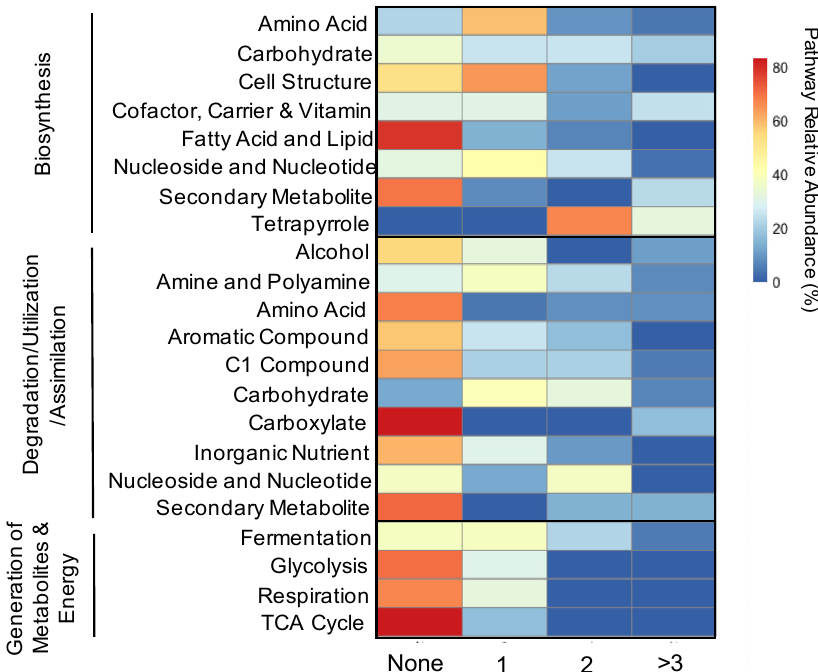
Figure 5. Relative abundances of inferred functional pathways between microbiomes of six species of Unionidae mussels sampled at the same site on the Sipsey River, AL, USA, across two years. Pathways that were not significantly different (adjusted p < 0.05) in any species (None) are presented alongside pathways that were found to be significantly different in one (1), two (2), and at least three (<3) species sampled in 2019 compared to 2016. Color denotes the percentage of inferred pathways. Parent functional pathways are labeled from the MetaCyc database version 2019. Mussel species were Lampsilis ornata , Obovaria unicolor , Elliptio arca , Fusconaia cerina , Cyclonaias asperata , and Tritogonia verrucosa